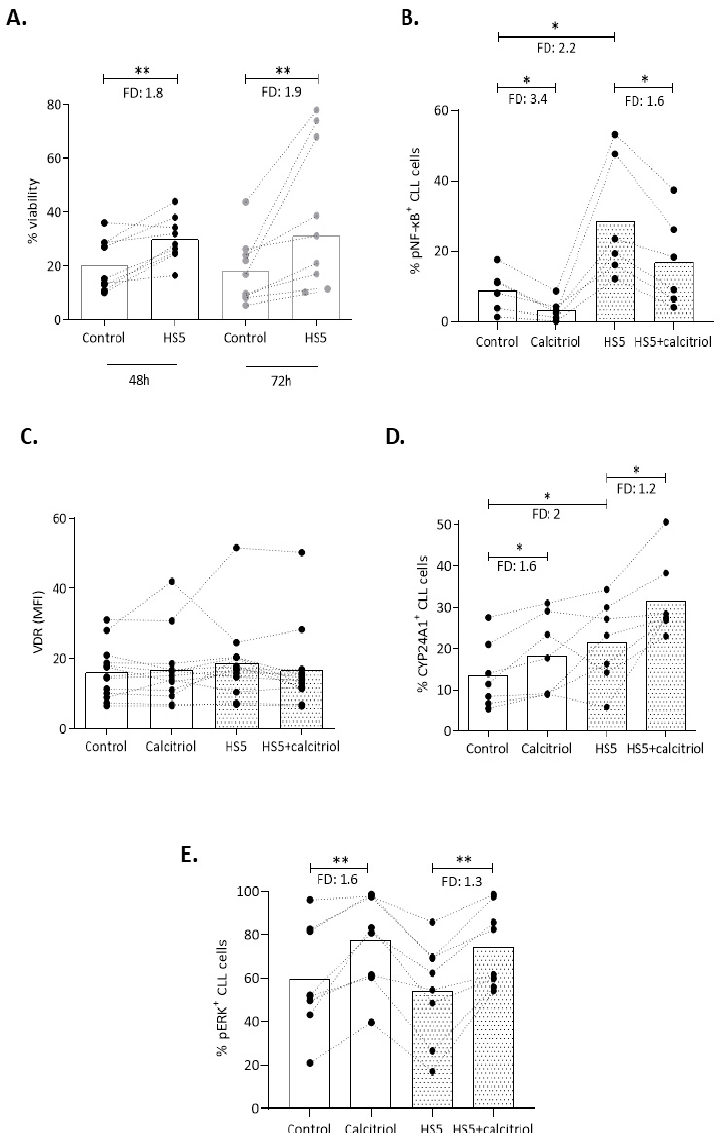
Figure 5. Co-culture of CLL cells with HS5 mesenchymal cells affects VDR signaling pathway, but not calcitriol action. ( A ) Viability of mono- vs co-cultured CLL cells was assessed by flow cytometry at 48 and 72 h of cell culture. ( B – E ) CLL cells from U-CLL cases were co-cultured with the HS5 stromal cell line and both mono- and co-cultured CLL cells were treated with calcitriol for 24 h. ( B ) pNF- κ B + cells, ( C ) VDR (MFI), ( D ) CYP24A1 + , and ( E ) pERK + cells were determined by flow cytometry. Bars represent the median values and the Wilcoxon test was performed to assess statistical significance. * p < 0.05, ** p <0.01, FD: Fold